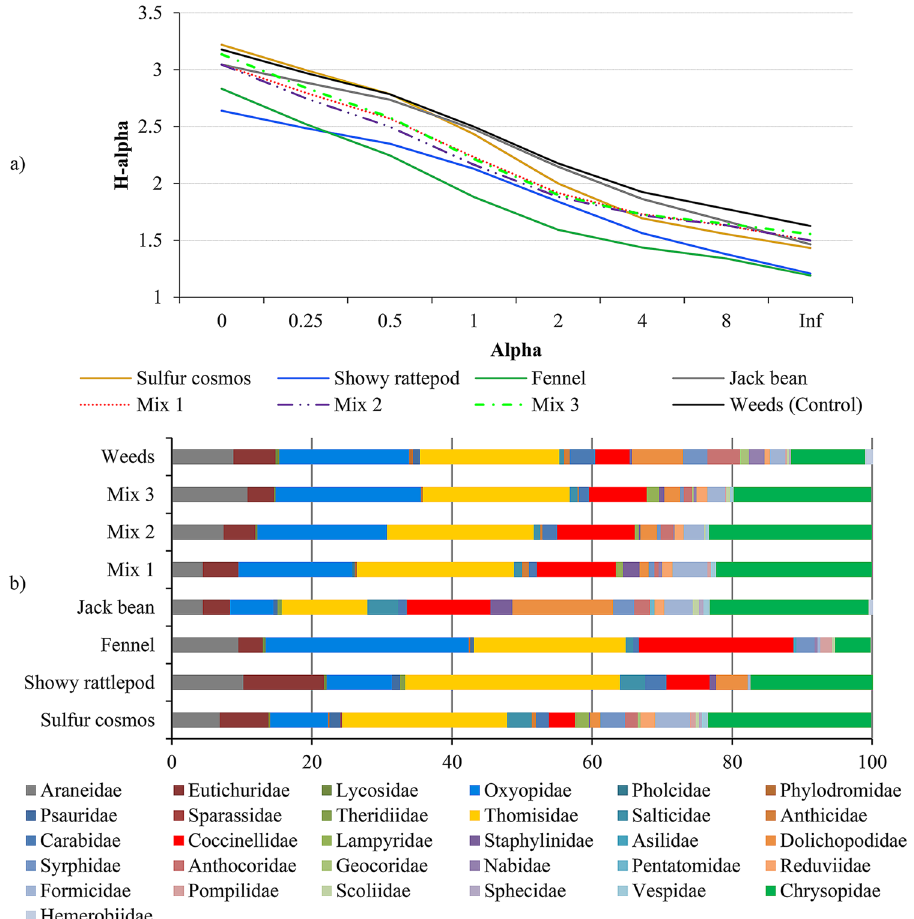
Figure 2. Rényi diversity profiles ( a ) and mean frequency of predatory arthropods ( b ) captured in single- cropping and intercropped systems (mixes) a , and weeds (control). Seropédica, RJ, Brazil, July to November 2017. a Mix1, 2, and 3 represent the intercropping of sulfur cosmos ( Cosmos sulphureus ), showy rattlepod ( Crotalaria spectabilis ), fennel ( Foeniculum vulgare ), and jack bean ( Canavalia ensiformis ) in three cultivation densities 10.8, 14.3, and 21.5 plants m −2 ,